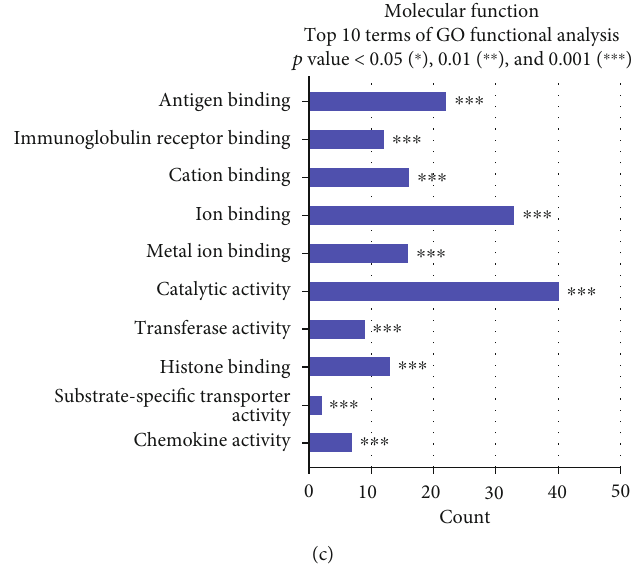
Figure 5: Functional category enrichment analysis of DEGs. The y -axis shows signi fi cantly enriched gene ontology (GO) terms, and the x -axis shows the counts of these terms. GO analysis included three categories: (a) biological processes, (b) cellular components, and (c) molecular